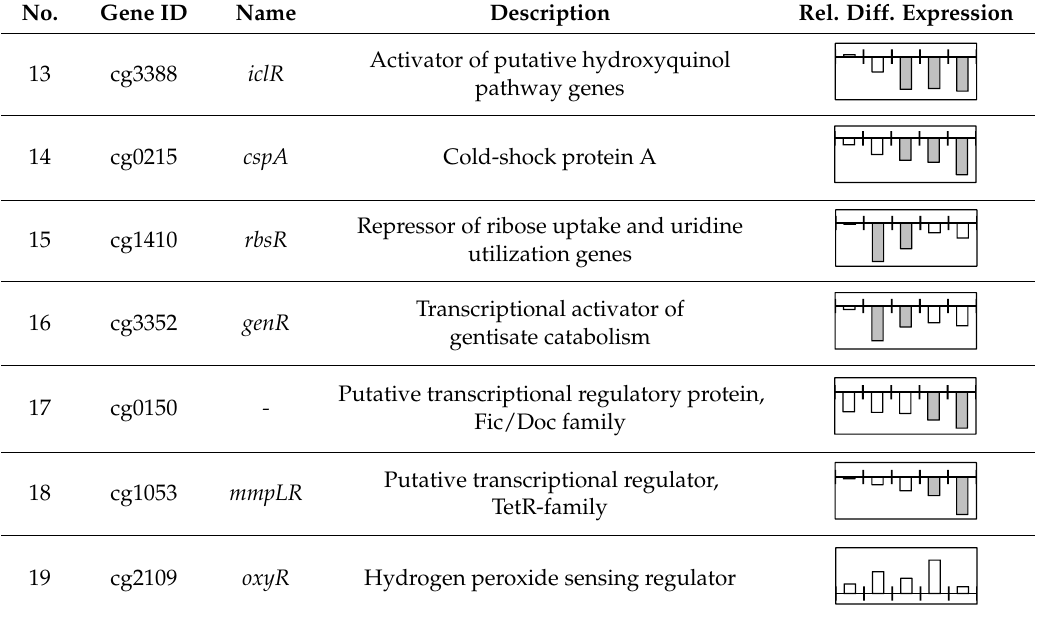
28 of 34 Table A3. outside the significance anaerobiosis ( ⑥ ) versus the aerobic reference ( ① ; Figure 1A). No.